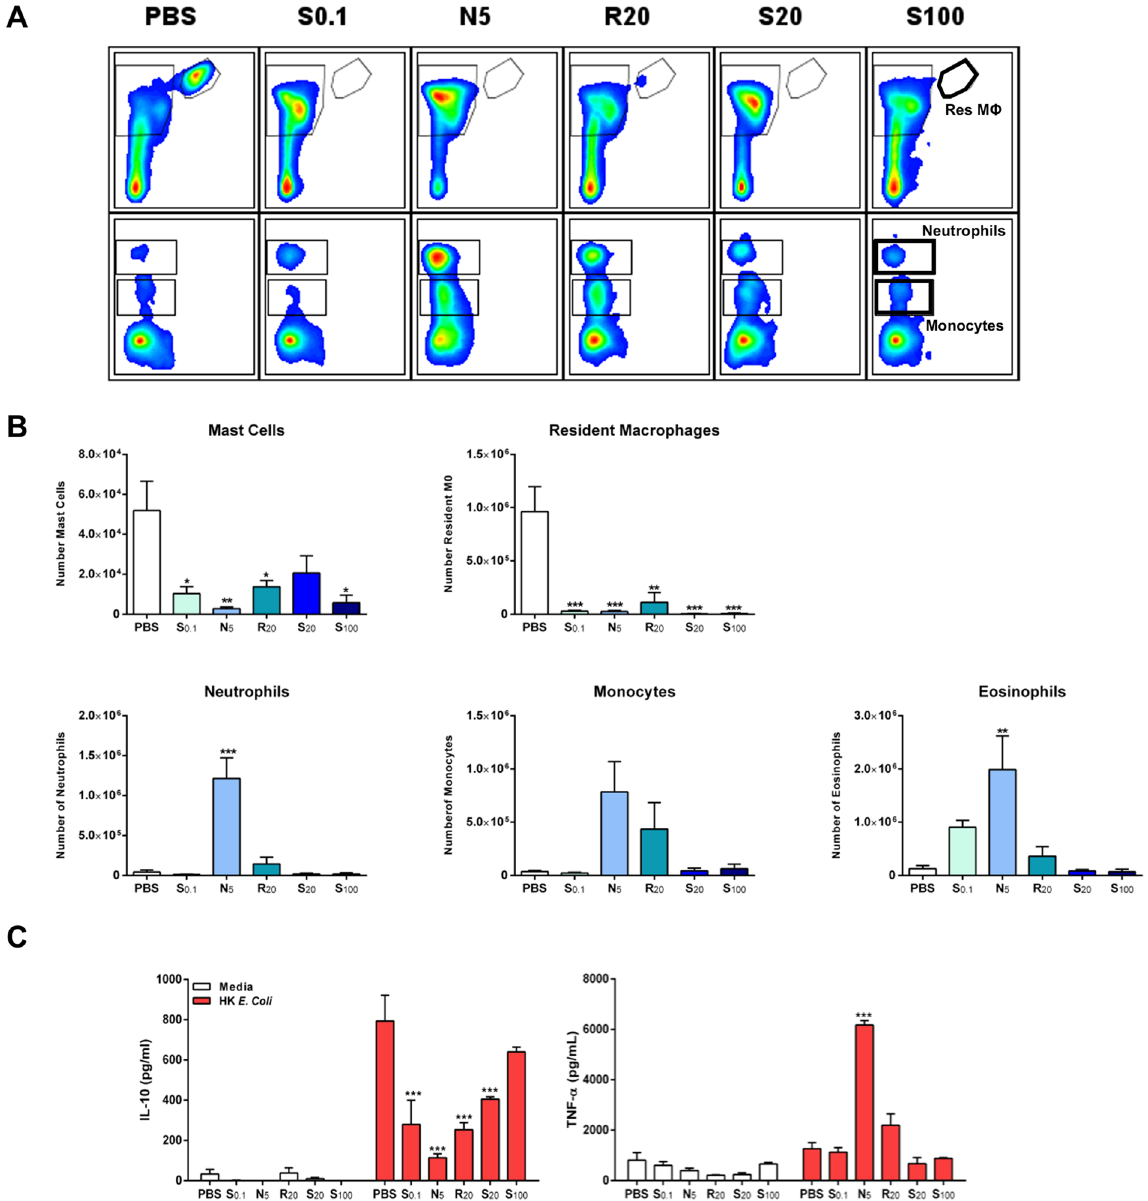
Figure 5. Size and shape dictates HA particle induced modulation of cytokine production following injection. Female C57BL/6 mice (n = 3) aged 6–8 weeks were injected intraperitoneally with PBS vehicle, S 0.1 (1 mg/ mouse), N 5 (1 mg/mouse), R 20 (1 mg/mouse), S 20 (1 mg/mouse) or S 100 (1 mg/mouse) HA particles, and 24 h later, peritoneal lavage cells were collected. ( A , B ) PECs were stained to analyse cell recruitment by flow cytometry. Cells were characterized using a combination of markers for peritoneal resident macrophages (CD11b hi F4/80 hi ), mast cells (SiglecF − cKit + ) monocytes (CD11b + SiglecF − F4/80 − Gr1 int SSC low ), neutrophils (CD11b + SiglecF − F4/80 − Gr1 hi ) and eosinophils (CD11b + SiglecF + Gr1 − SSC hi ). Results are representative of two independent experiments. ( A ) Representative plots ( B ) Data are expressed as number of single/live cells. ( * p < 0.05, ** p < 0.01, *** p < 0.001). ( C ) PECs were restimulated with complete RPMI 1640 medium or heat- killed Escherichia coli (10 bacteria/cell) for 24 h. Supernatants were assessed for IL-10 and TNF- α secretion by ELISA. Results are mean cytokine concentrations ( ± SEM) for triplicate samples (vs PBS *** p <